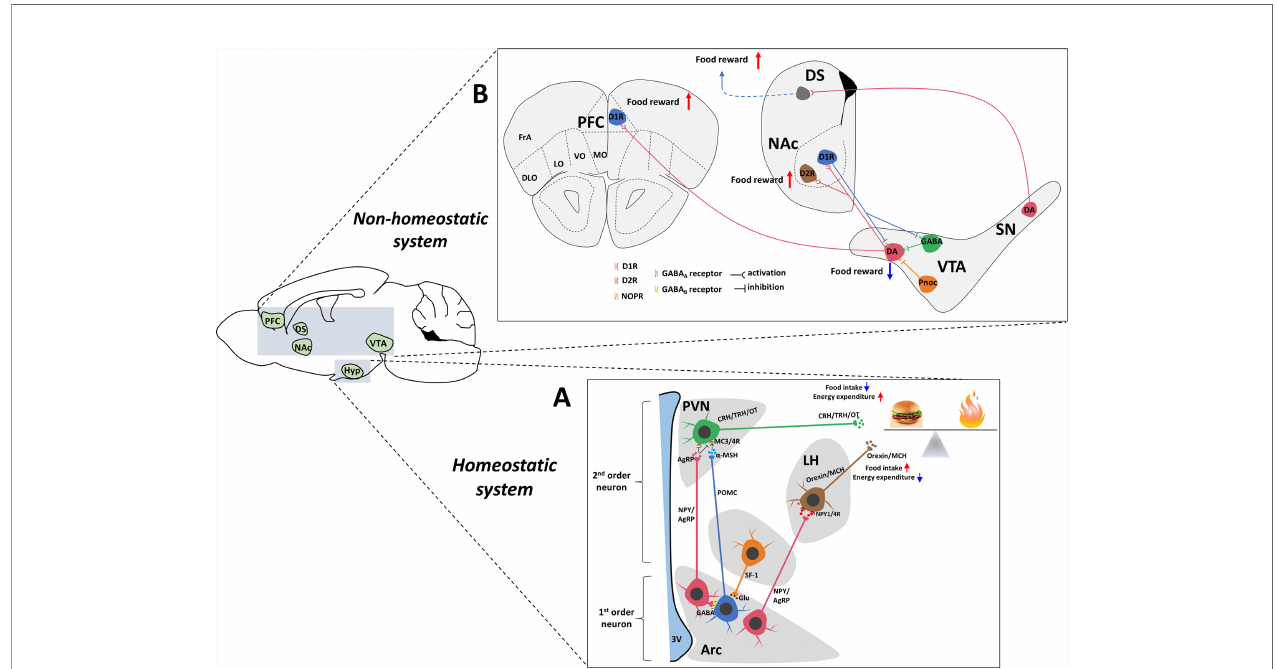
FIGURE 1 | Central neuronal circuits involved in homeostatic and non-homeostatic systems. (A) Hypothalamic regulation of energy homeostasis. The Arc of the hypothalamus contains two groups of neurons: NPY/AgRP and POMC neurons. These neurons secrete orexigenic AgRP/NPY or anorexigenic POMC to the second-order neurons in the PVH and LH. In the PVN, neurons produce OT, TRH and CRH to decrease food intake. Neurons in the LH produce ORX and MCH to increase food intake. AgRP is an antagonist of anorectic MC4R expressed on neurons within the PVN. In the Arc, a local circuit exists in which POMC neurons receive GABAergic (inhibitory) input from NPY/AgRP neurons. The SF-1 nerve located in the VMH innervates POMC/CART neurons to enhance the anorexia function of POMC/CART neurons and is critically involved in the regulation of energy homeostasis. (B) The dopamine system, which contains connections between the midbrain and forebrain. The reward pathway includes dopaminergic neurons in the ventral tegmental area that project to the NAc and PFC. Dopamine, which is released from dopaminergic neurons in the VTA, binds to D1R or D2R in the NAc and D1R in the PFC, which contribute to food reward. In turn, D1R also inhibits DA and GABAergic neurons in the VTA through different GABA receptors to form negative feedback regulation. The VTA also contains GABAergic cells and Pnoc neurons that project to DA neurons to inhibit DA activity. In addition, DA neurons located in the SN also project to the DS, which potentially increases food reward behavior. Hyp, hypothalamus; Arc, arcuate nucleus; LHA, lateral hypothalamus area; PVN, paraventricular nucleus of the hypothalamus; VMH, ventromedial hypothalamus; 3V, 3rd ventricle; VTA, ventral tegmental area; NAc, nucleus accumbens; PFC, prefrontal cortex; DS, dorsal striatum; SN, substantia nigra; AgRP, agouti-related peptide; NPY, neuropeptide Y; POMC, proopiomelanocortin; Glu, glutamate; GABA, gamma-aminobutyric acid; MCH, melanin-concentrating hormone; a -MSH, a -melanocyte-stimulating hormone; CRH, corticotropin-releasing hormone; TRH, thyrotropin-releasing hormone; OT, oxytocin; DA, dopamine; D1R, dopamine 1 receptor; NOPR, nociceptin opioid peptide